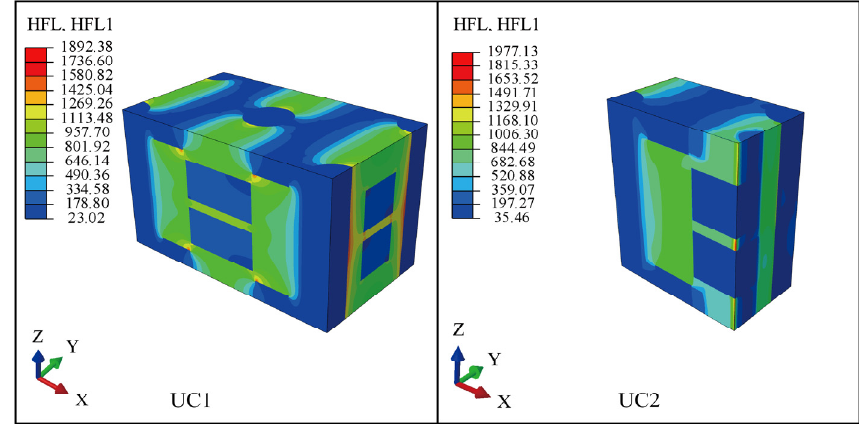
λ in UC1 and UC2.